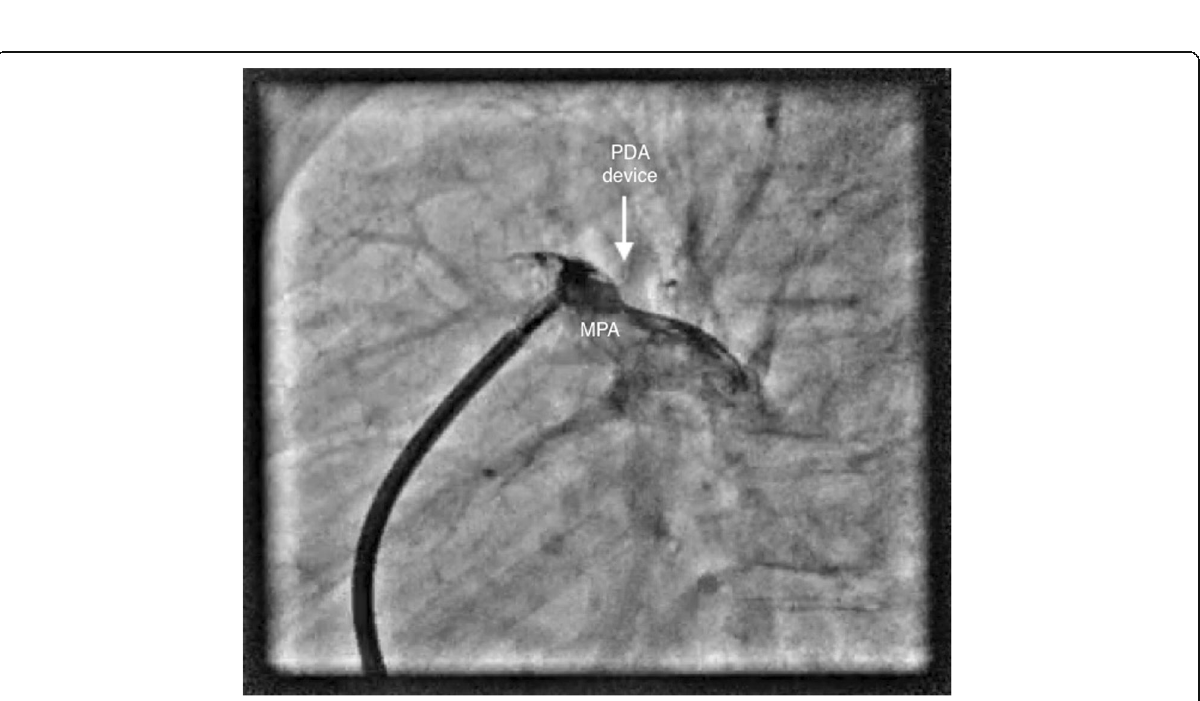
Fig. 3 The position of the PDA device is ascertained by continuous hand injection via the long delivery sheath filling pulmonary